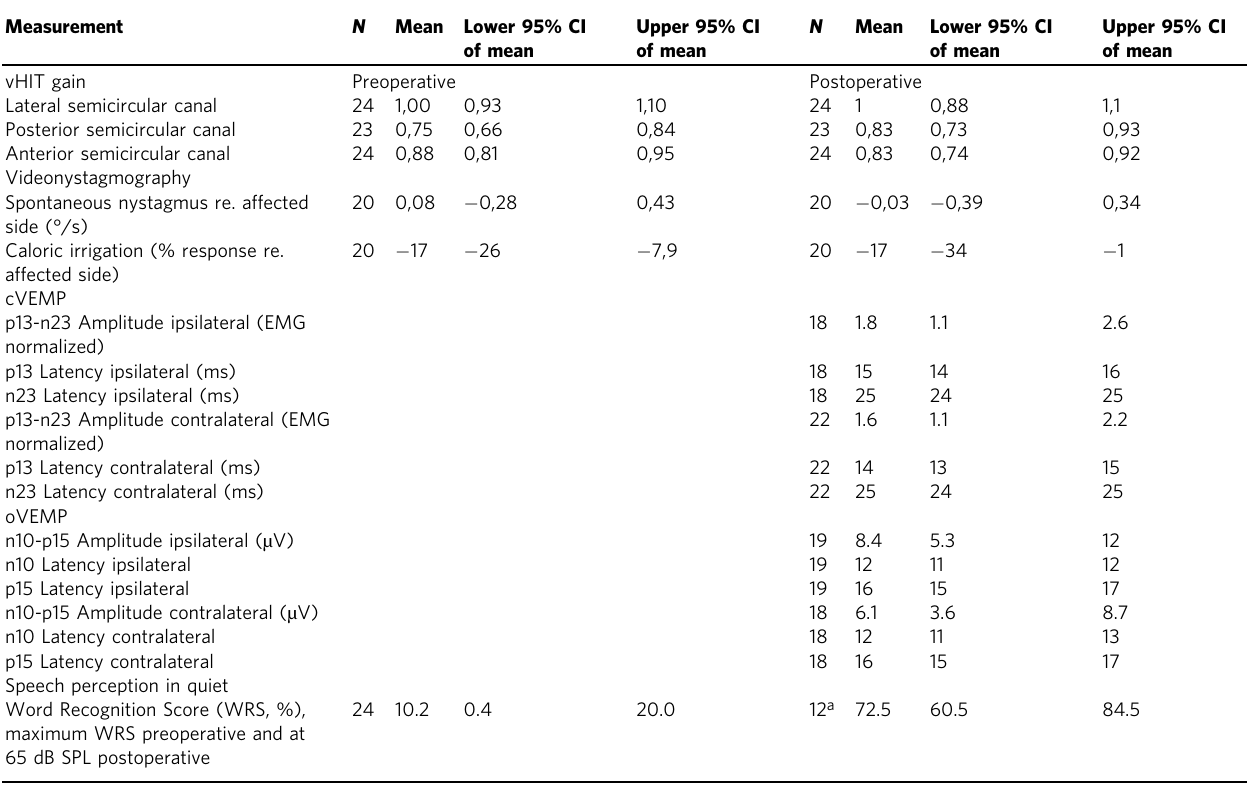
Table. 1 Functional test results before and after partial or subtotal cochlear removal. Measurement